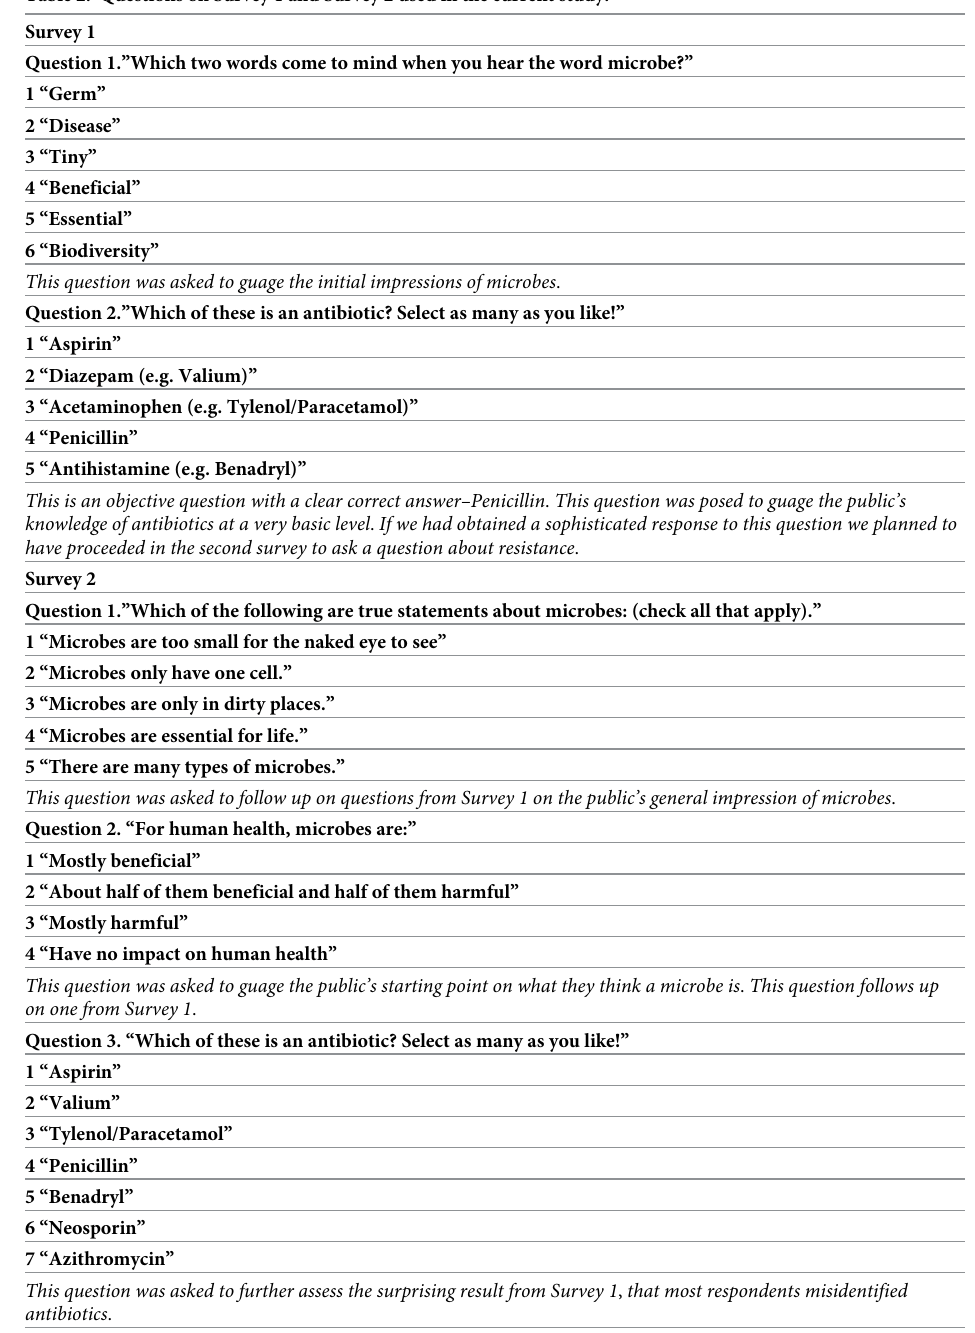
Table 2. Questions on Survey 1 and Survey 2 used in the current